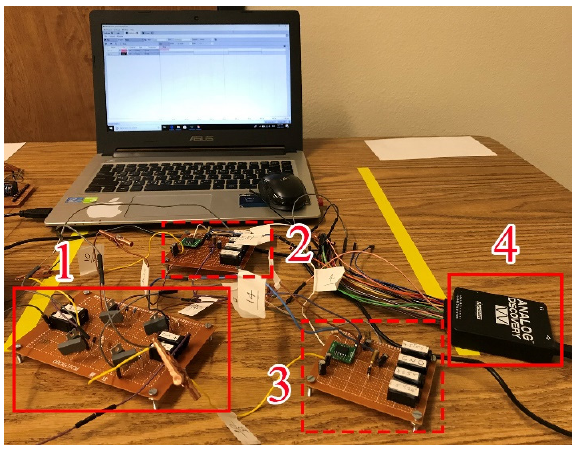
Figure 14. Prototype of GaN inverter including RCD snubber circuit; 1: Full-bridge GaN inverter, 2: 1st gate driver, 3: 2nd gate drive, 4: Sending signals to the gate drivers.